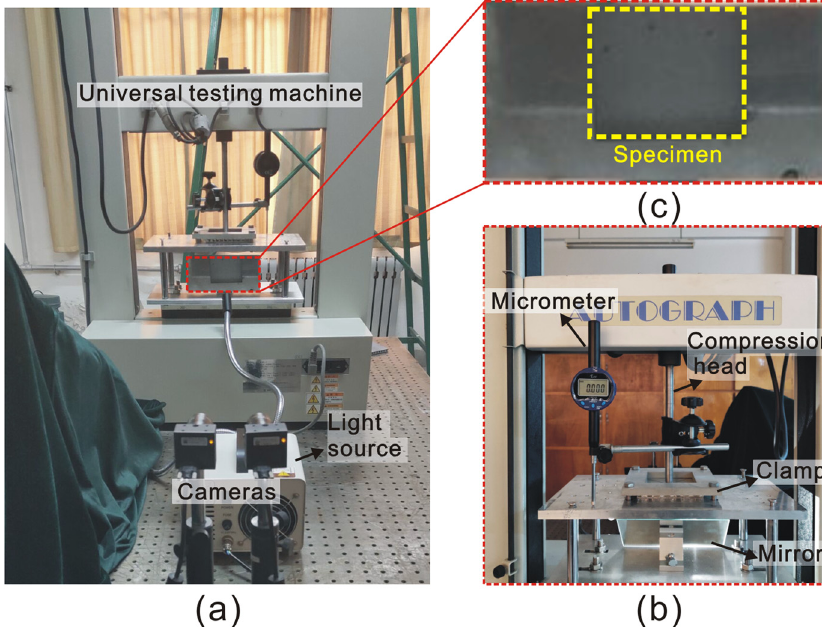
Figure 2: ( a ) Experimental set - up for QSI test, ( b ) clamping fi xture, and ( c )